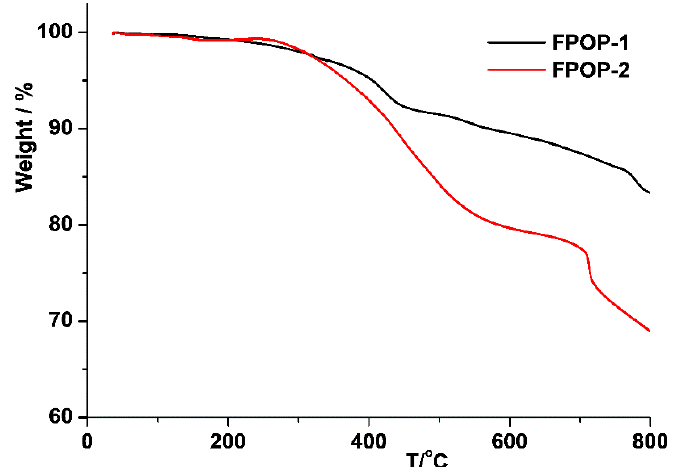
Figure 5. TGA curves of FPOP-1 and FPOP-2 in nitrogen atmosphere.